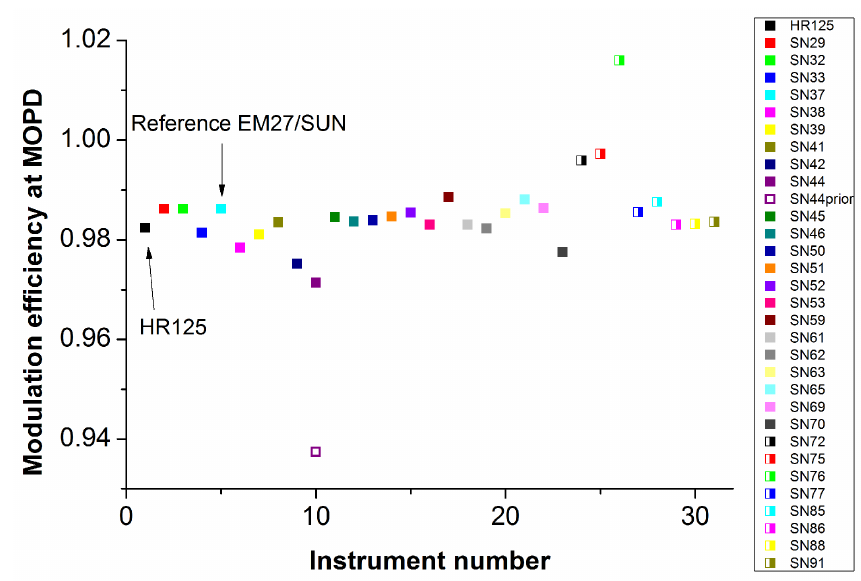
Figure 9. Modulation efficiencies at MOPD for all EM27/SUN tested in Karlsruhe. For SN44 prior, ILS measurements were taken before an alignment check and subsequent realignment of the instrument. For comparison reasons, an ILS measurement for the HR125 was also